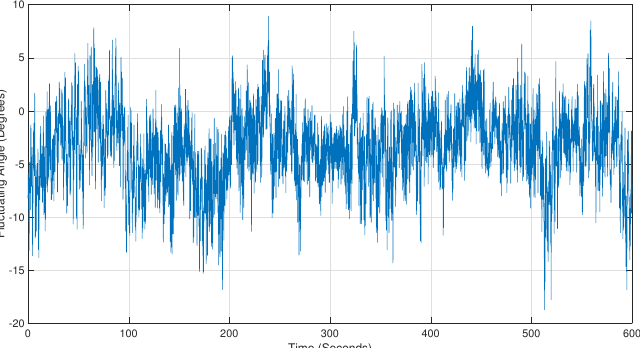
Figure 8. Aeroelastic model results for fluctuating angle between hub thrust and lateral forces for an above-rated wind speed of 22